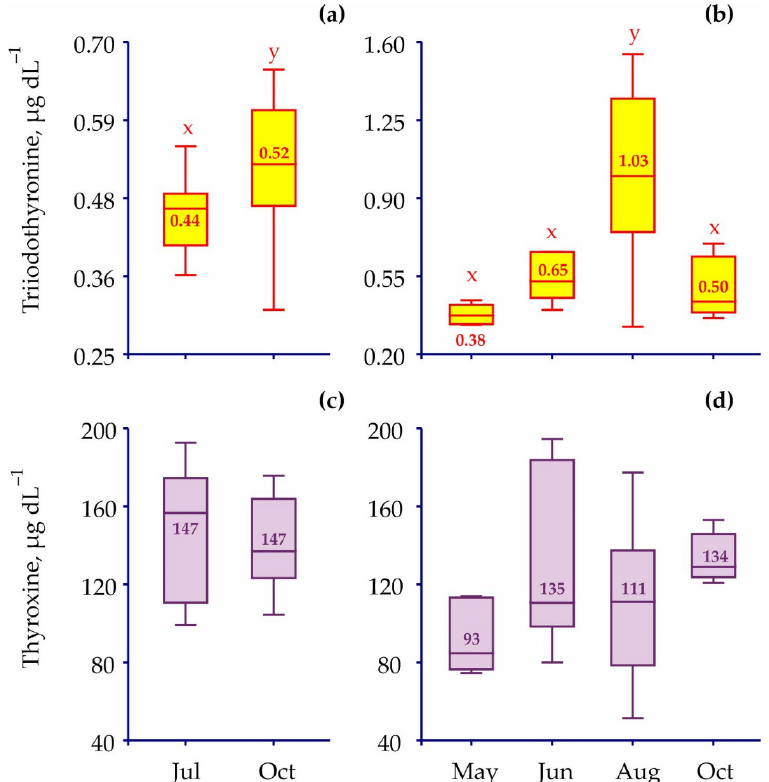
Figure 4. Seasonal variations in thyroid hormones in hemolymph of red king crabs from the coastal Barents Sea (box plots). Numbers indicate mean levels. Bars with the same letter are not signifi- cantly different ( p > 0.05). ( a ) Triiodothyronine, juveniles; ( b ) triiodothyronine, adults; ( c ) thyroxine, juveniles; ( d ) thyroxine,